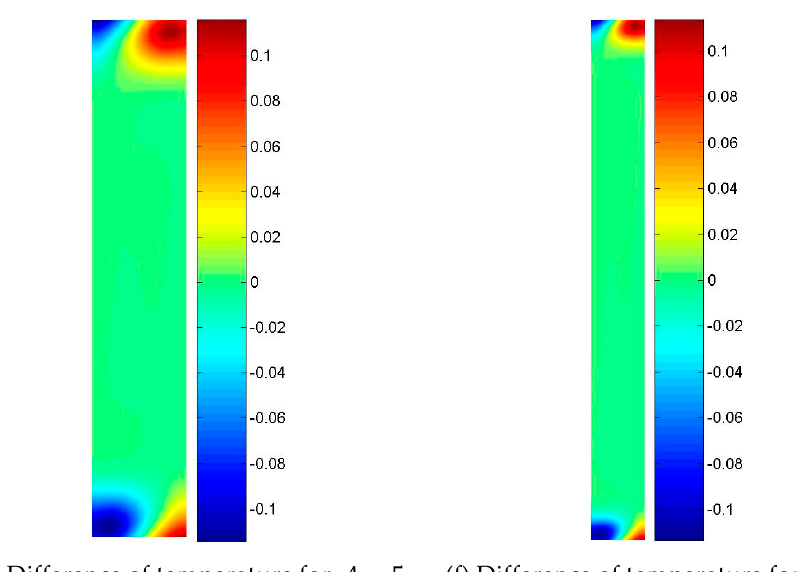
Table 3. Nusselt numbers for the analytical and numerical solutions at varying (cid:1827) and with (cid:1844)(cid:1853) = 10 (cid:2872) .